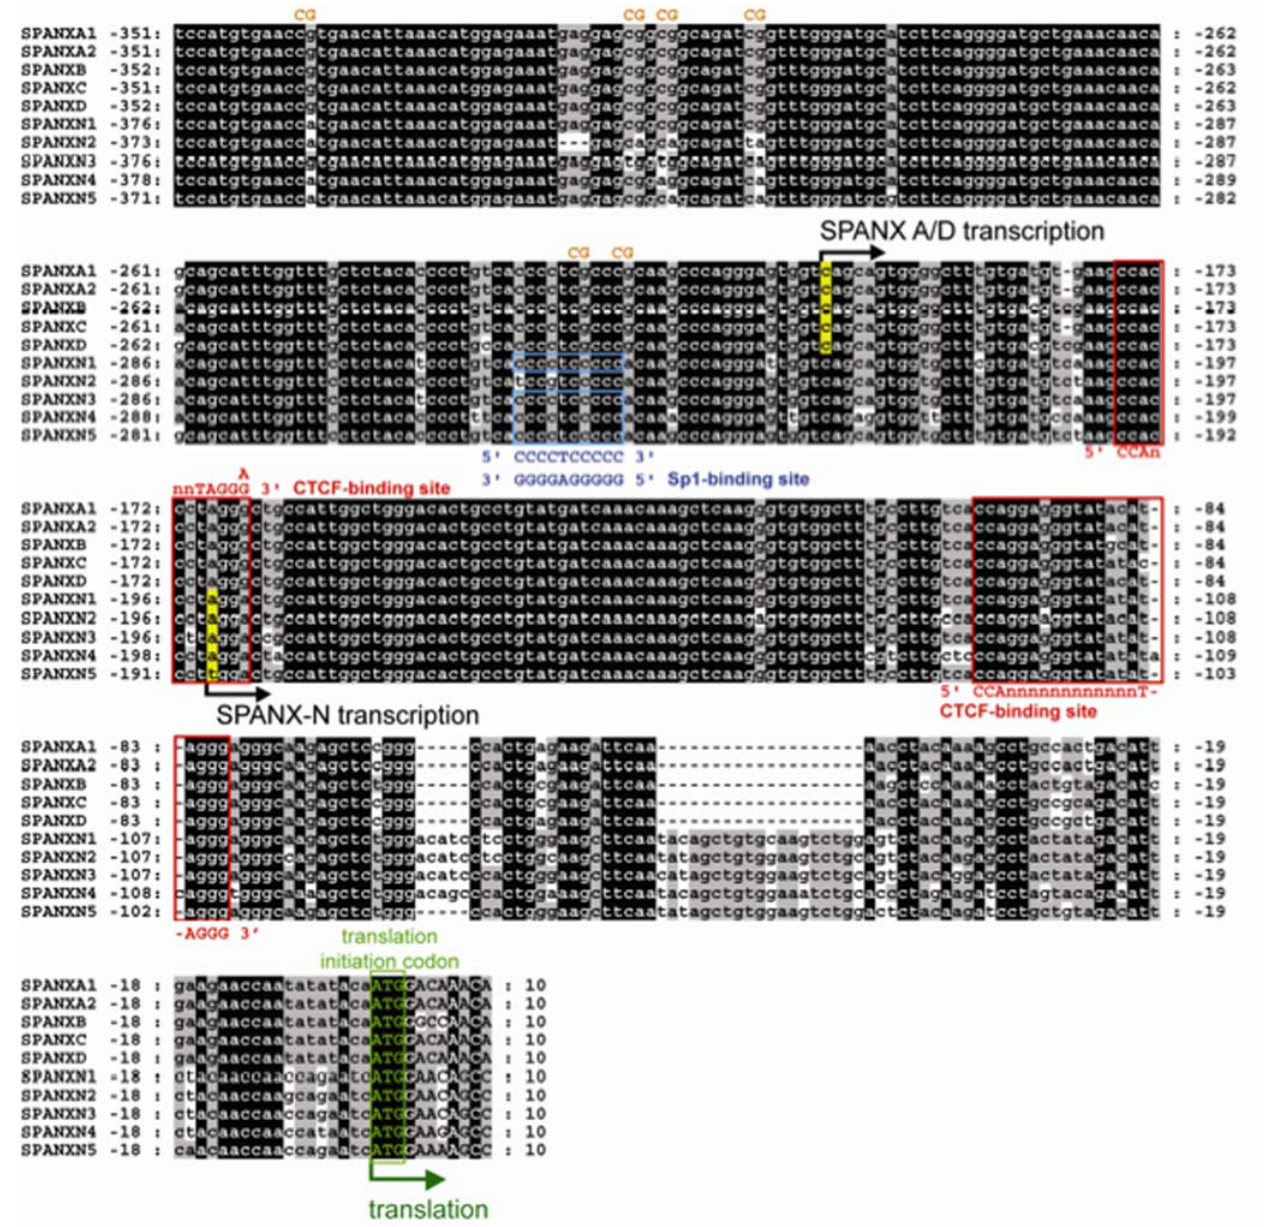
Figure 8. Comparison of human SPANX-A/D and SPANX-N promoters. Detected transcription starts are marked in yellow, the translation initiation codons ATG are marked in green. Noncoding sequences are in lowercase. SPANX-N copies differ from SPANX-A/D genes by the almost complete lack of all CpG dinucleotides in the promoter regions (in orange); however, these CpGs are perfectly preserved in all of the SPANX-A/D copies. CpG sites are marked only on one strand. Sp1 binding consensus in four SPANX-N copies is marked in blue. CTCF-binding sites are marked by red